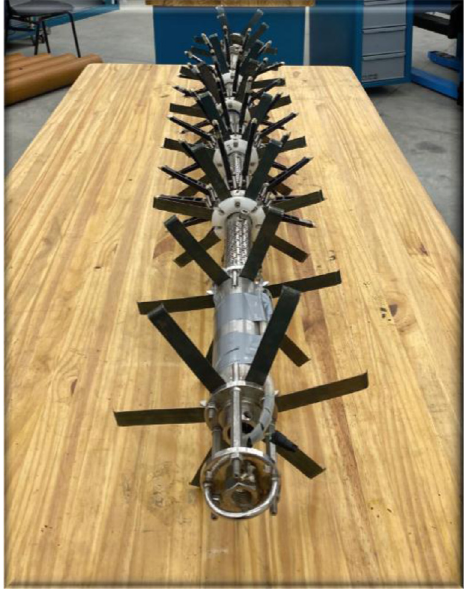
Fig. 1. Multidimensional Feeler PIG.